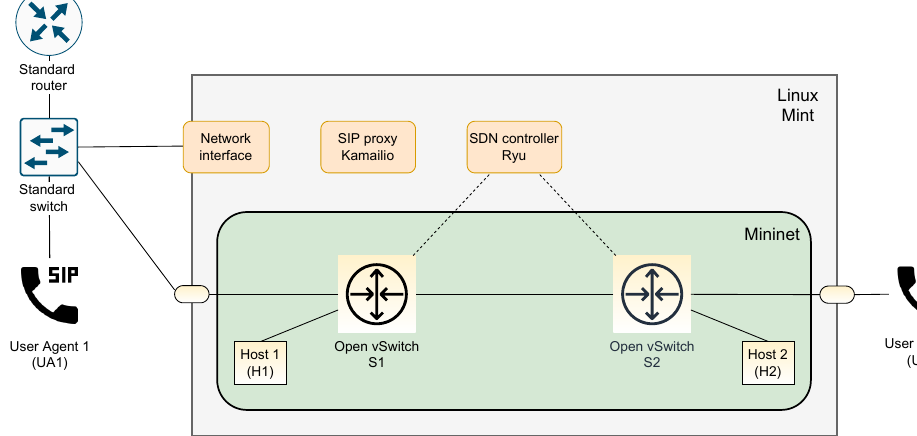
Figure 1. Physical